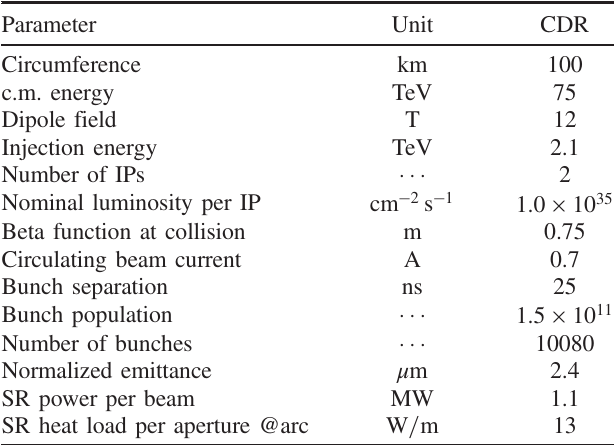
TABLE IV. Main parameters of the